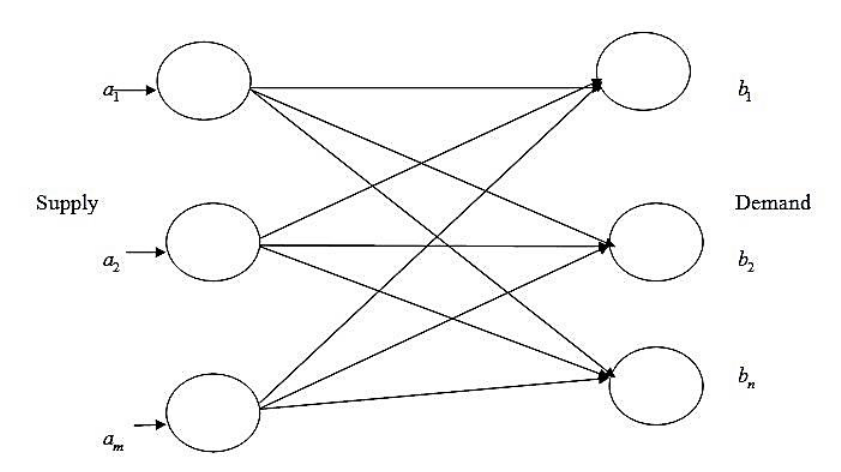
Fig. 1. LP Transportation